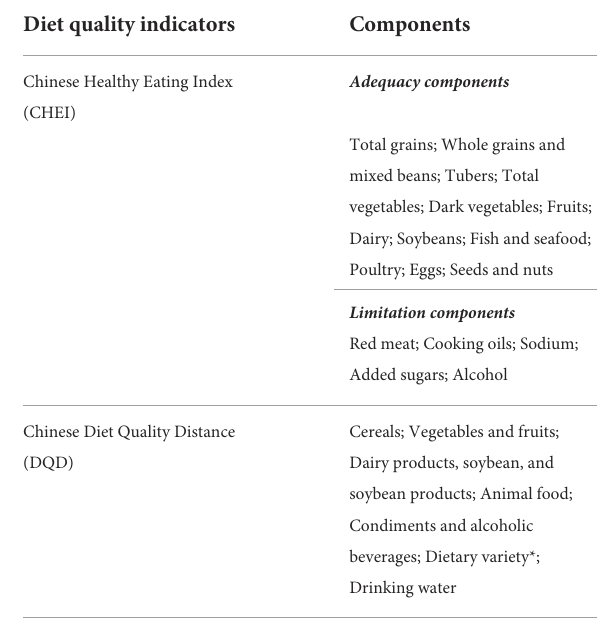
TABLE 1 Components of diet quality